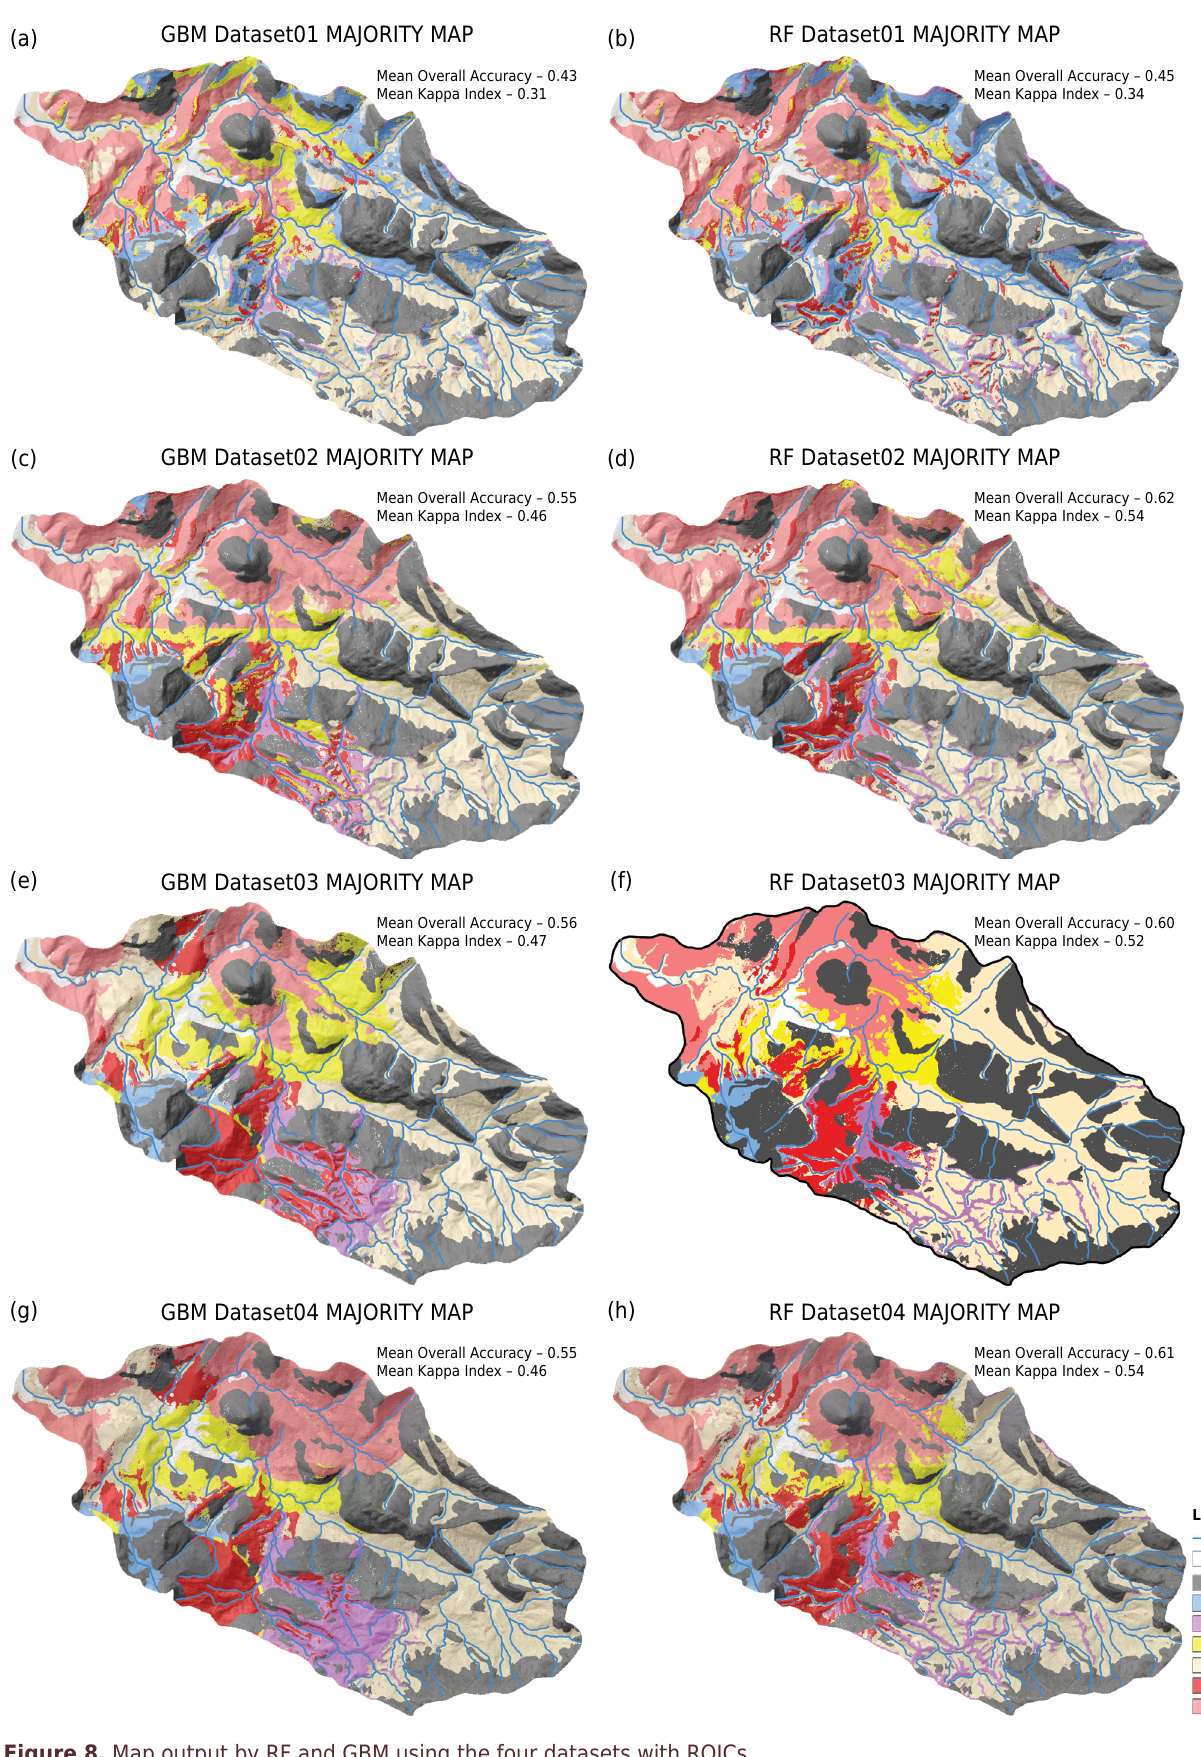
Figure 8. Map output by RF and GBM using the four datasets with